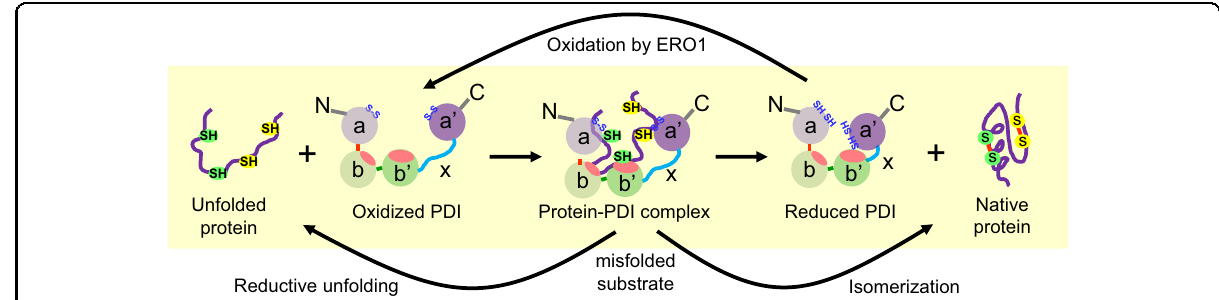
Fig. 1 Protein folding by PDI in the ER. Oxidizing equivalents are transferred from the active site disul fi de bonds (Cys53-Cys56 and Cys397-Cys400) of oxidized PDI to the reduced substrate. In turn, PDI is reduced and reoxidized by ERO1 in the ER environment. Misfolded substrates are reduced and reoxidized or directly isomerized. The x-linker region (X) is also indicated. The highly acidic region (c) is not shown here. N and C represent the N- and C-terminus,